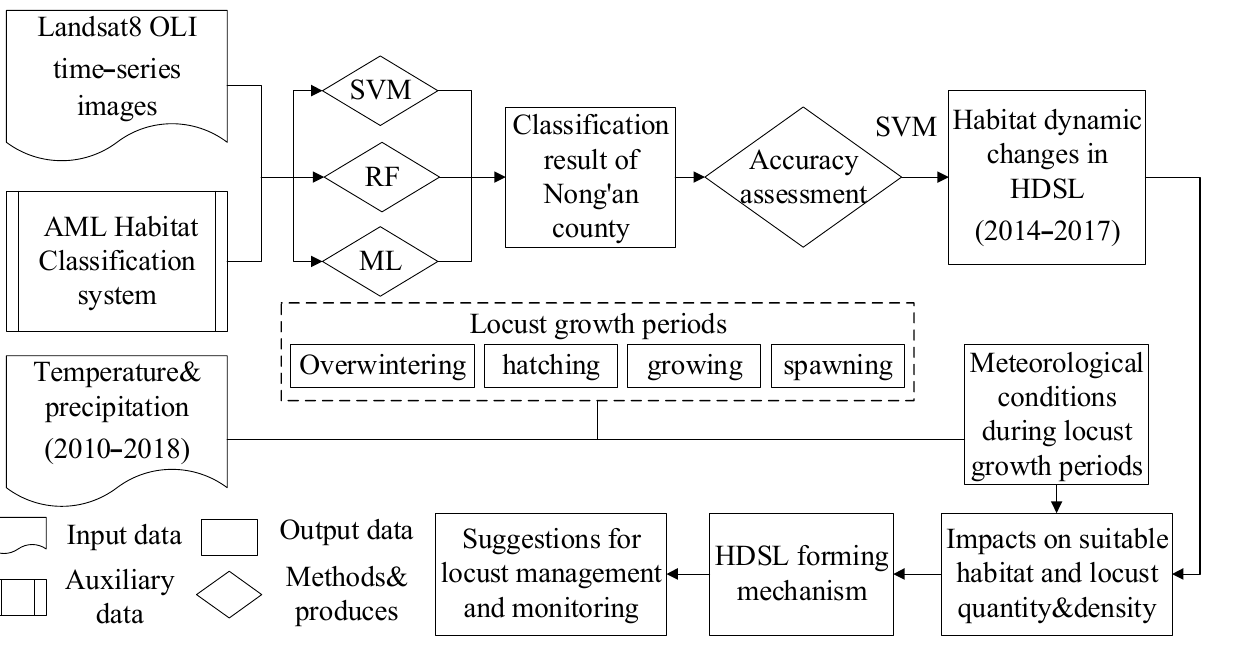
Figure 2. Flowchart of the forming mechanism of the high-density spot of locust. AML, Asian migratory locust; SVM, support vector machine; RF, random forest; ML, maximum likelihood; HDSL, high-density spot of locust.